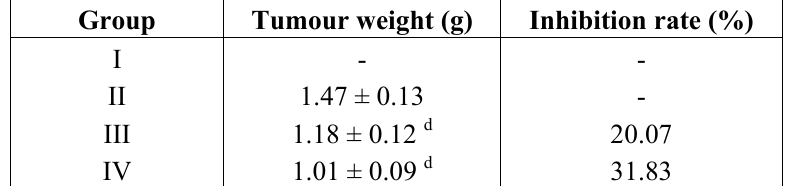
Table 1. Sodium aescinate injection liquid affecting tumour inhibition rate. Group